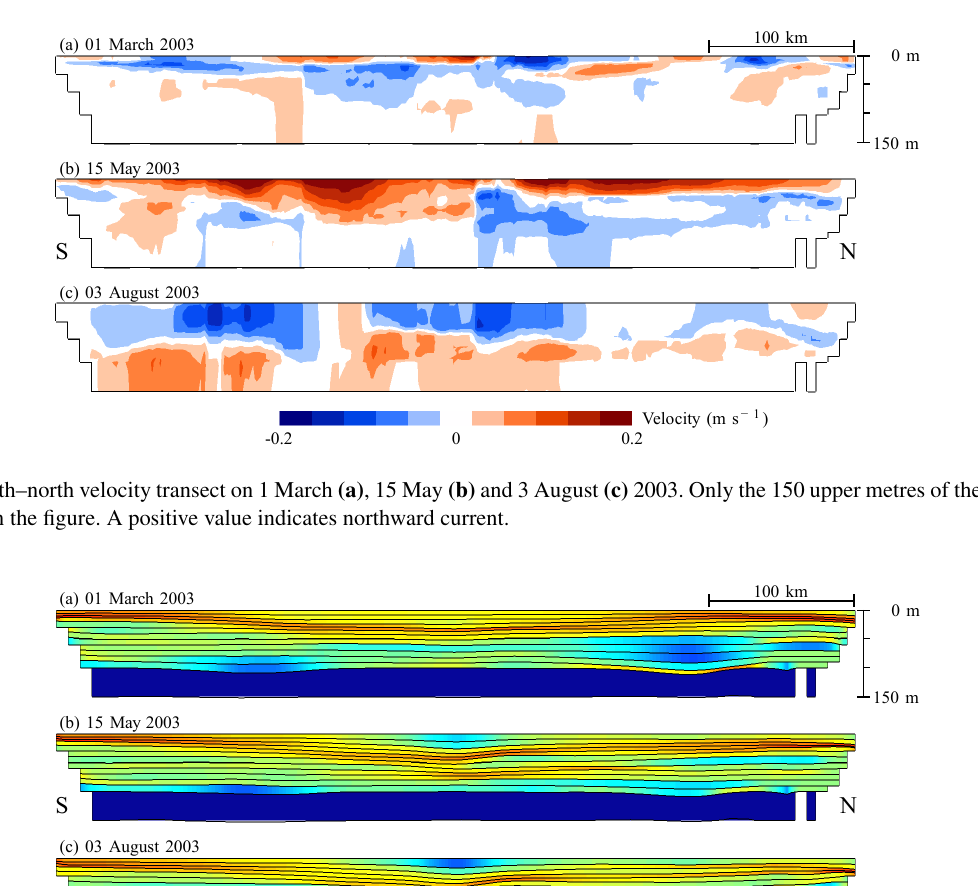
Figure 17. South–north temperature transect on 1 March (a) , 15 May (b) and 3 August (c) 2003. Only the 150 upper metres of the vertical profile are displayed in the figure.